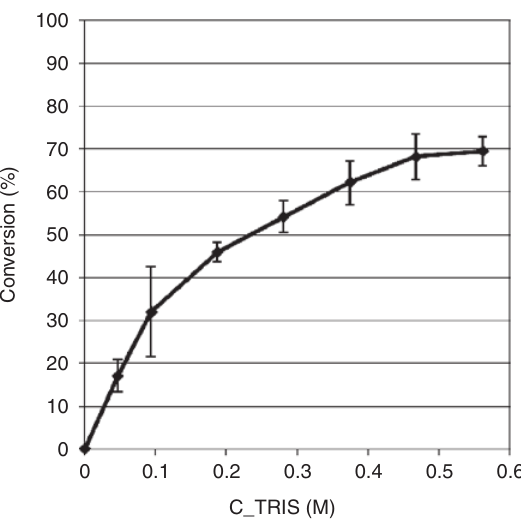
Figure 4: Removal of ppm levels of benzaldehyde (starting con- centration 5 ppm) in the water/ethanol solvent mixture by using different molar concentrations of tris(hydroxymethyl)aminomethane (TRIS) as a scavenger and with a reaction time of 1 h at a tempera- ture of 50 ° C.